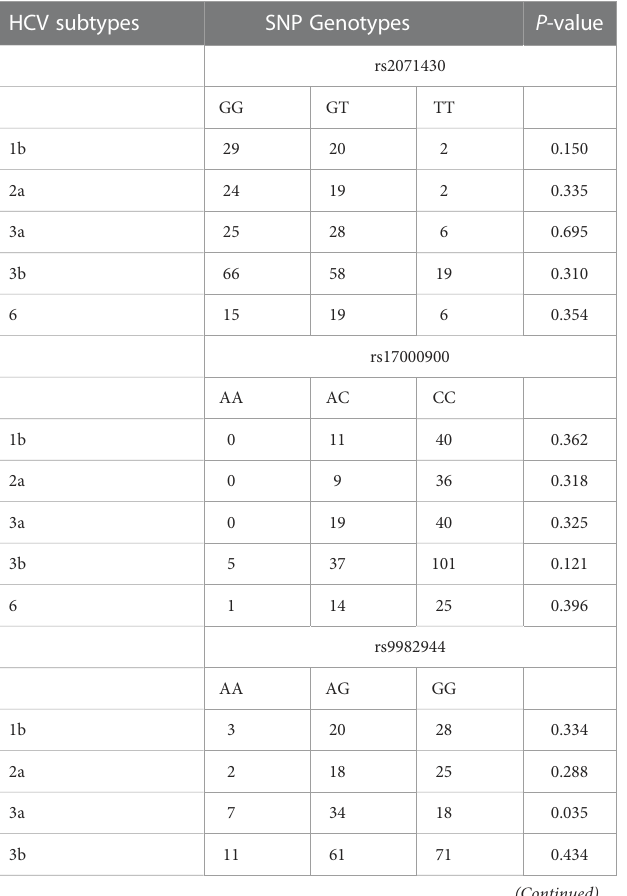
TABLE 3 HCV subtypes frequencies in patients carried with different SNP genotypes.